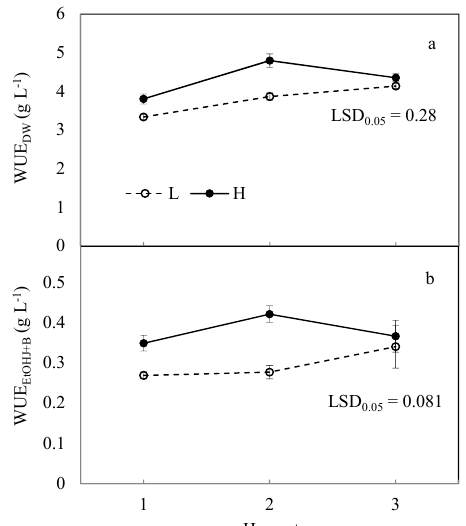
Figure 2. ( a ) Water use efficiency for sorghum dry weight (WUE DW ); and ( b ) for combined ethanol production (WUE EtOHJ+B ) with high (H) and low (L) soil moisture in three harvests. LSD 0.05 indicates least significant difference at p ≤ 0.05. Error bars represent ± standard deviation.